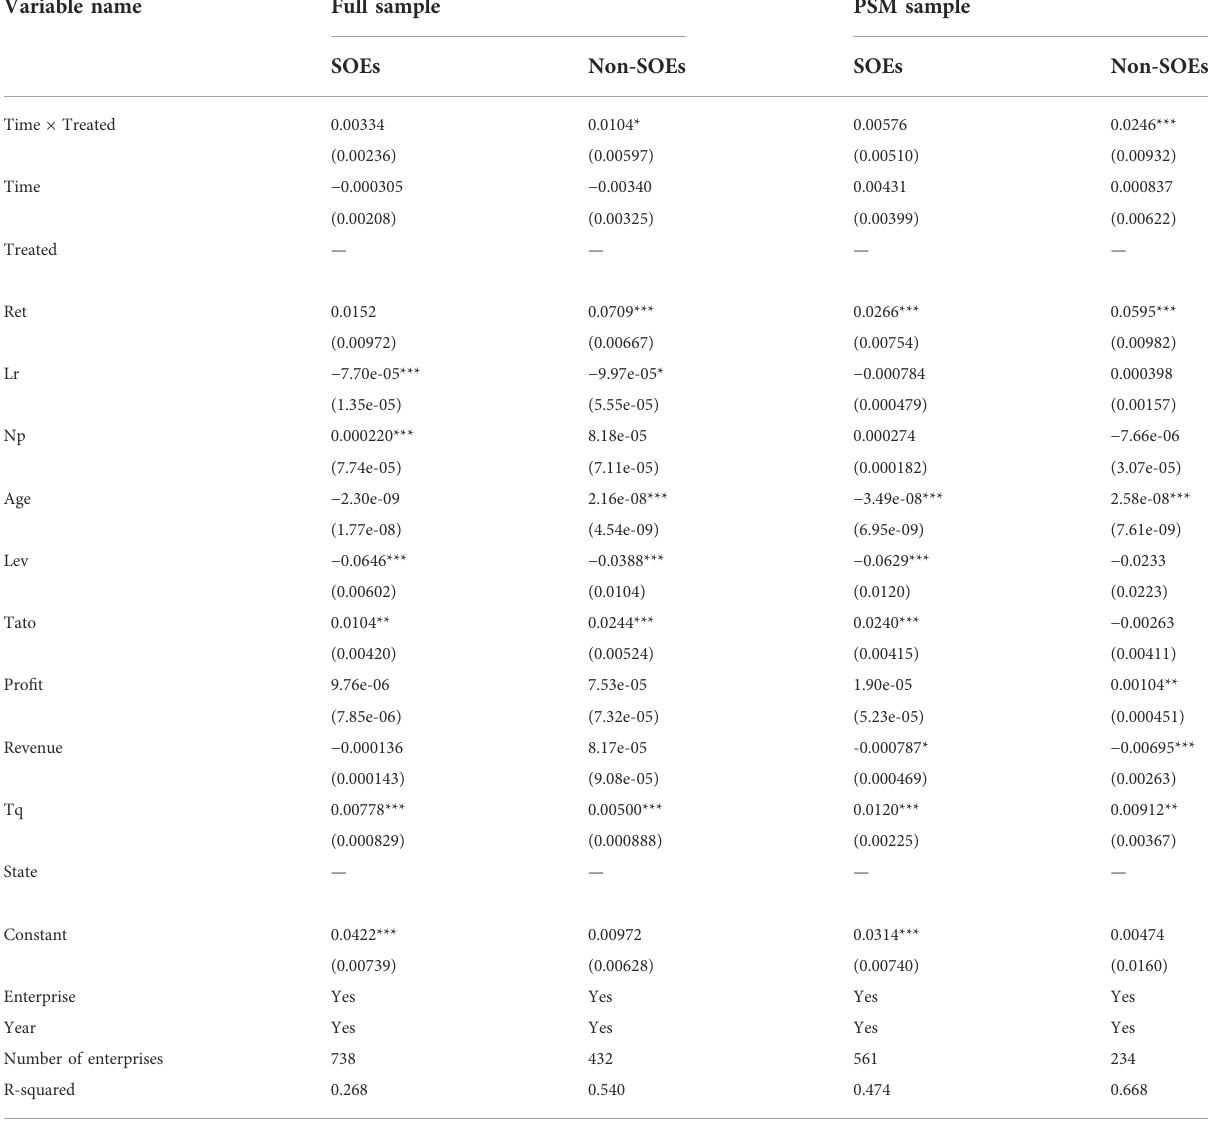
TABLE 8 A test of the impact of green credit policy on the fi nancial performance of construction energy-saving enterprises under the difference of controlling shareholders.